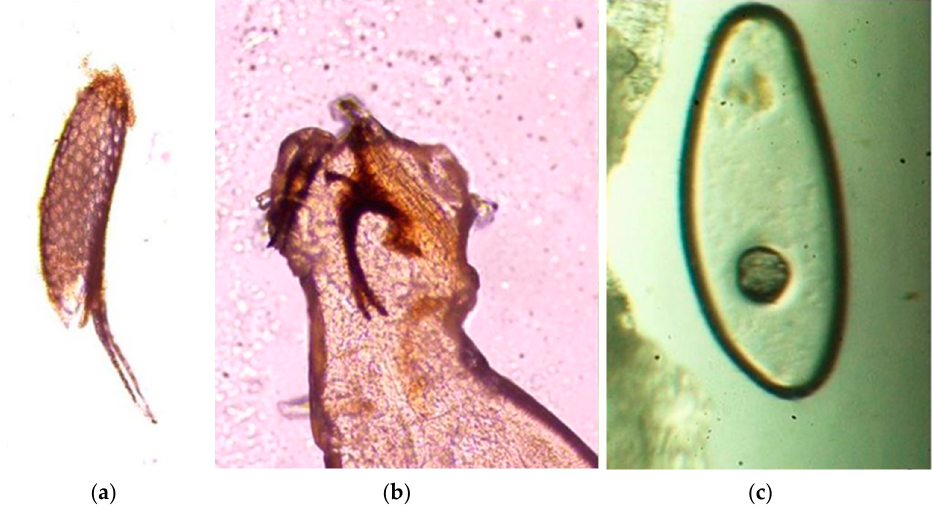
Figure 3. Organisms detected in fecal samples: ( a ) G. pecorum —inactive egg; ( b ) G. pecorum —larval head and oral hooks; ( c ) Paramecium sp.; not to scale.